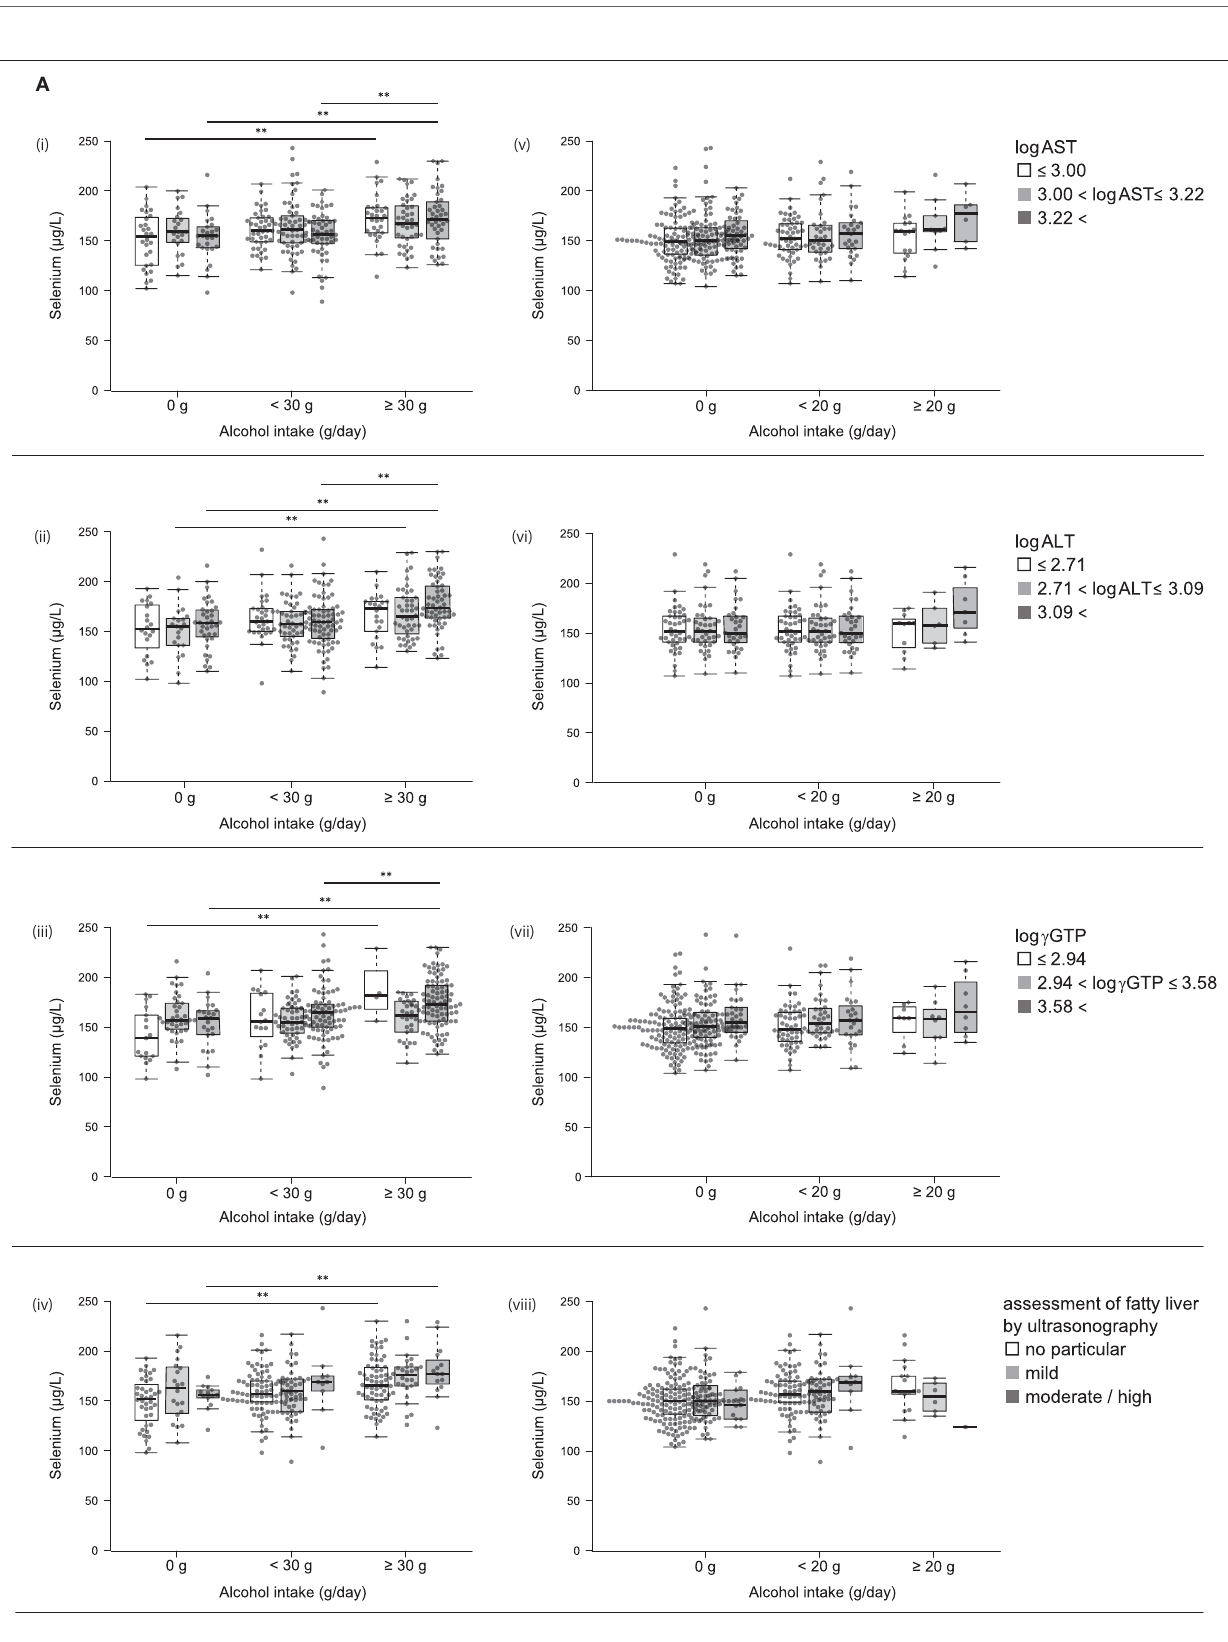
Frontiers in Nutrition |